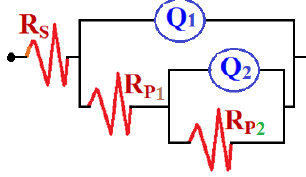
Figure 8. The equivalent circuit model used to fit the EIS experimental data.